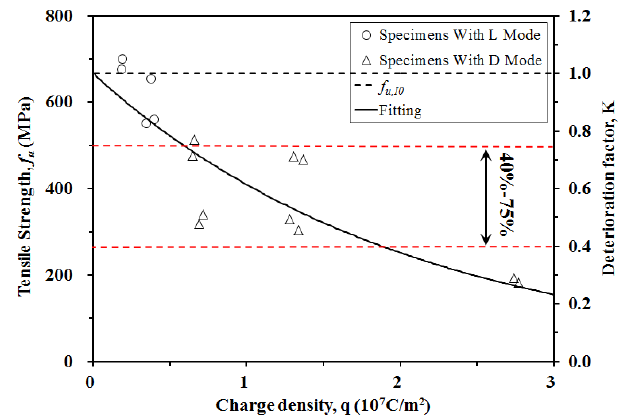
Figure 6. The relationship between tensile strength, K and charge density for CFRP specimens with pore solution subjected to anodic polarization.